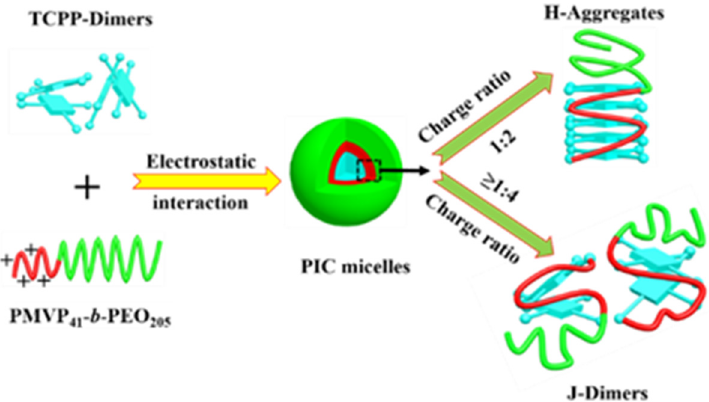
Figure 7. Molecular orbital diagrams calculated for TCPP and TCPP/ (PMVP ‐ PEO) 1 . PMVP ‐ PEO is an abbreviation of PMVP 41 ‐ b ‐ PEO 205 .